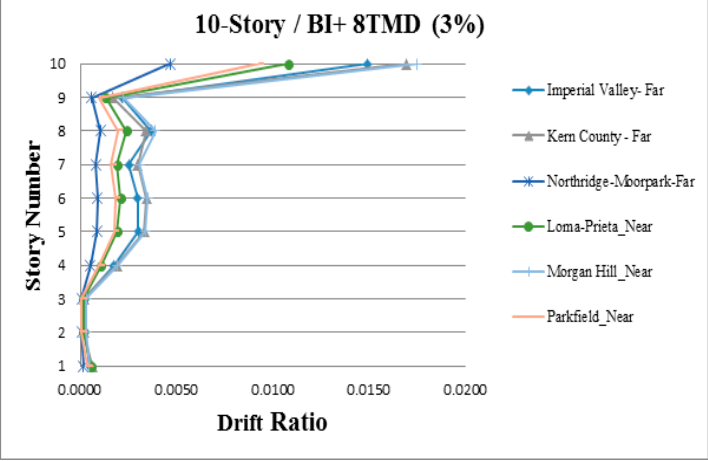
Figure 16. Drift ratios for 10-story base-isolated building with 8 TMDs.